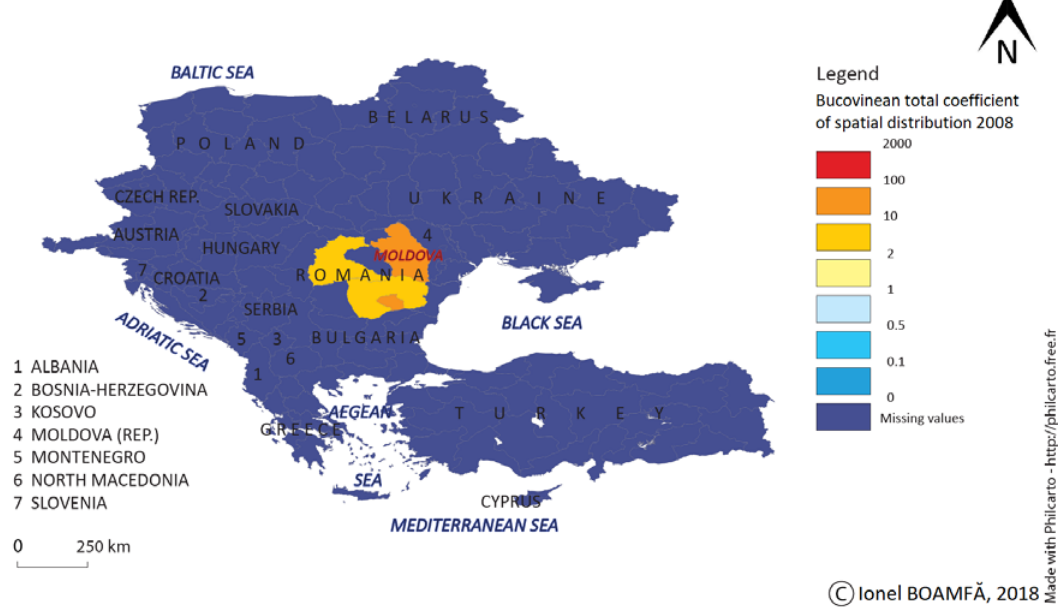
Figur e 3 . G eographical repartition of the anthroponym Bucovinean. Coef. of spatial distribution